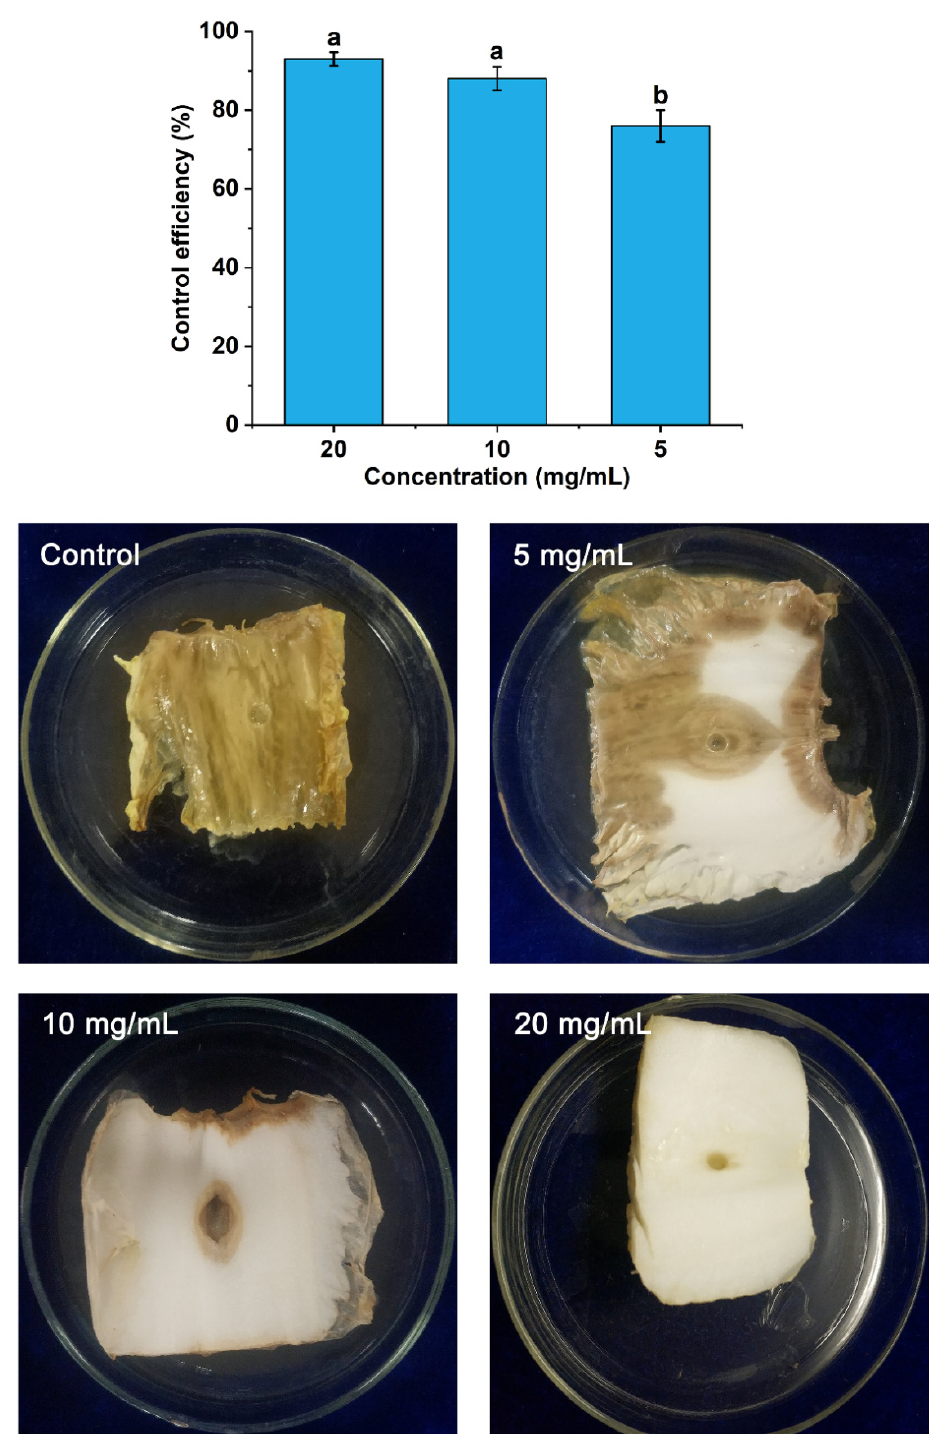
Figure 5. Curative activity of Polygonum orientale essential oil against Pectobacterium carotovorum subsp. carotovorum . The control was treated with 3% DMSO and 1% Tween 20. A significant difference was expressed ( p < 0.05).